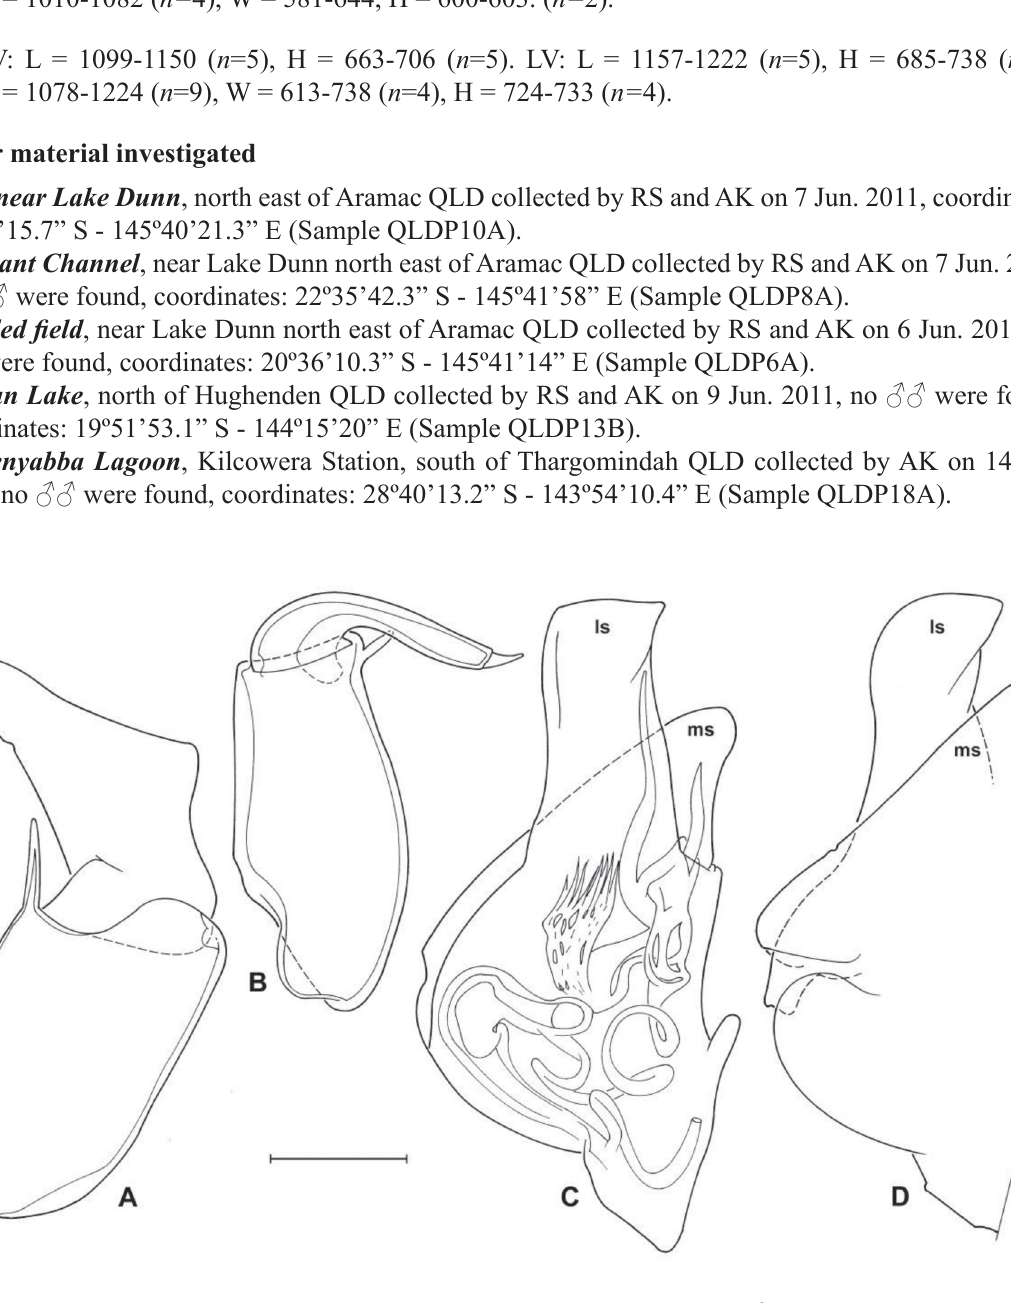
Fig. 5. Bennelongia dedeckkeri sp. nov. (A = W40017 & B-D = W40016 ♂). A . Right prehensile palp. B . Left prehensile palp. C . Hemipenis showing inner anatomy. D . Outline of other hemipenis. Scales: A-B = 30.9 μm, C-D = 89.3